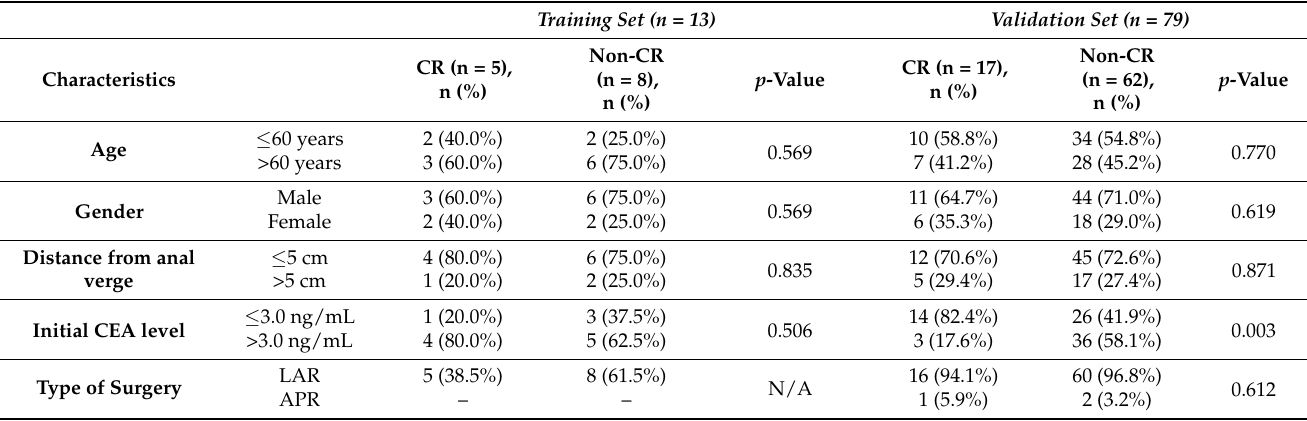
Table 1. Patients and tumor characteristics of training (n = 13) and validation sets (n = 79). Training Set (n =